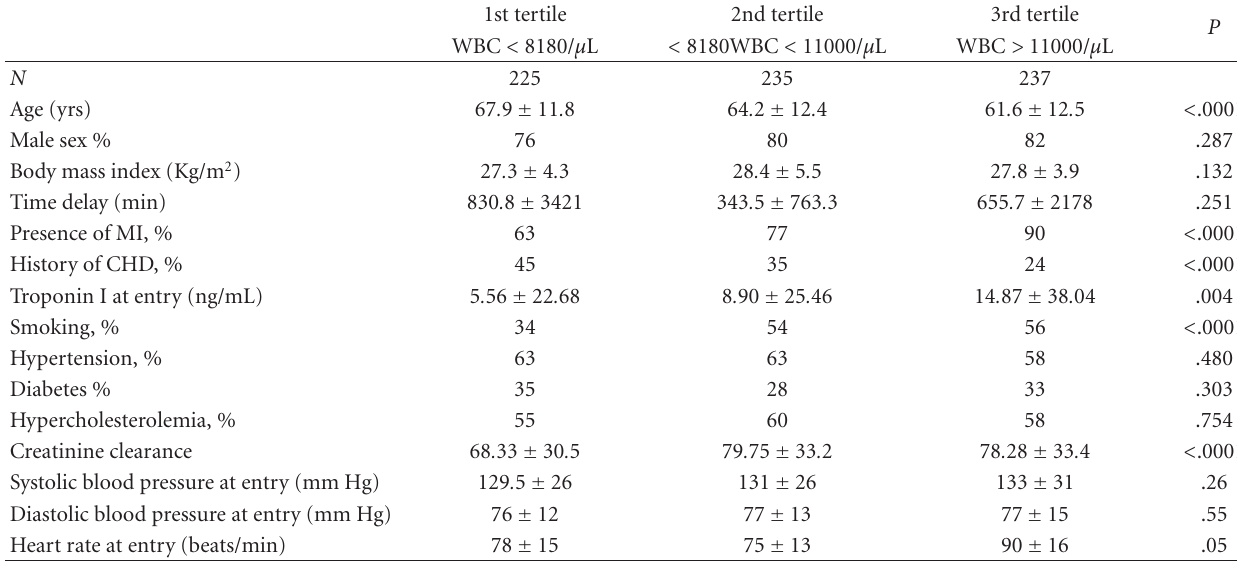
Table 2: Results from ANOVA that presents the distribution of clinical and biochemical characteristics among WBC tertile. 1st tertile